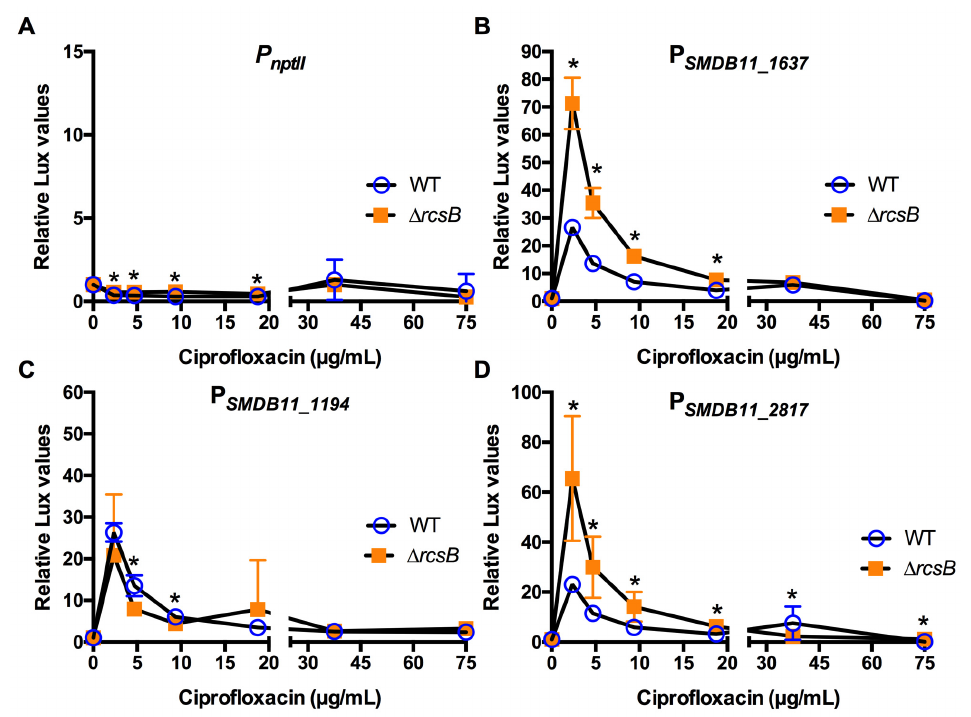
Figure 7. Effect of DNA metabolism-targeting ciprofloxacin on Rcs-activated promoters ( A – D ). Relative luminescence values were determined by dividing luminescence by optical density after 4 h of antibiotic challenge. The nptII promoter ( A ) was largely unaffected by ciprofloxacin. The experimental promoters ( B – D ) were activated to an equal or greater extent in the ∆ rcsB mutant than the WT. Mean and standard deviation are shown ( n = 6–9 are shown). Asterisks (*) indicate statistical differences between groups at the indicated concentrations, p < 0.05.